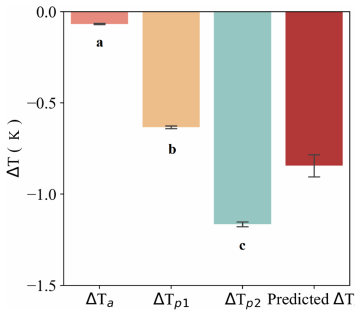
Figure 7. Comparison of (cid:49)T for the three approaches, irrespective of the afforestation intensity. Error bars are given as the standard error, and different letters indicate (cid:49)T being significantly differ- ent ( p = 0 . 0167, paired-sample t test, n = 96058). For comparison, the predicted (cid:49)T a with F aff reaching 100%, which is conceptually comparable with (cid:49)T p and (cid:49)T p , is also 1 2